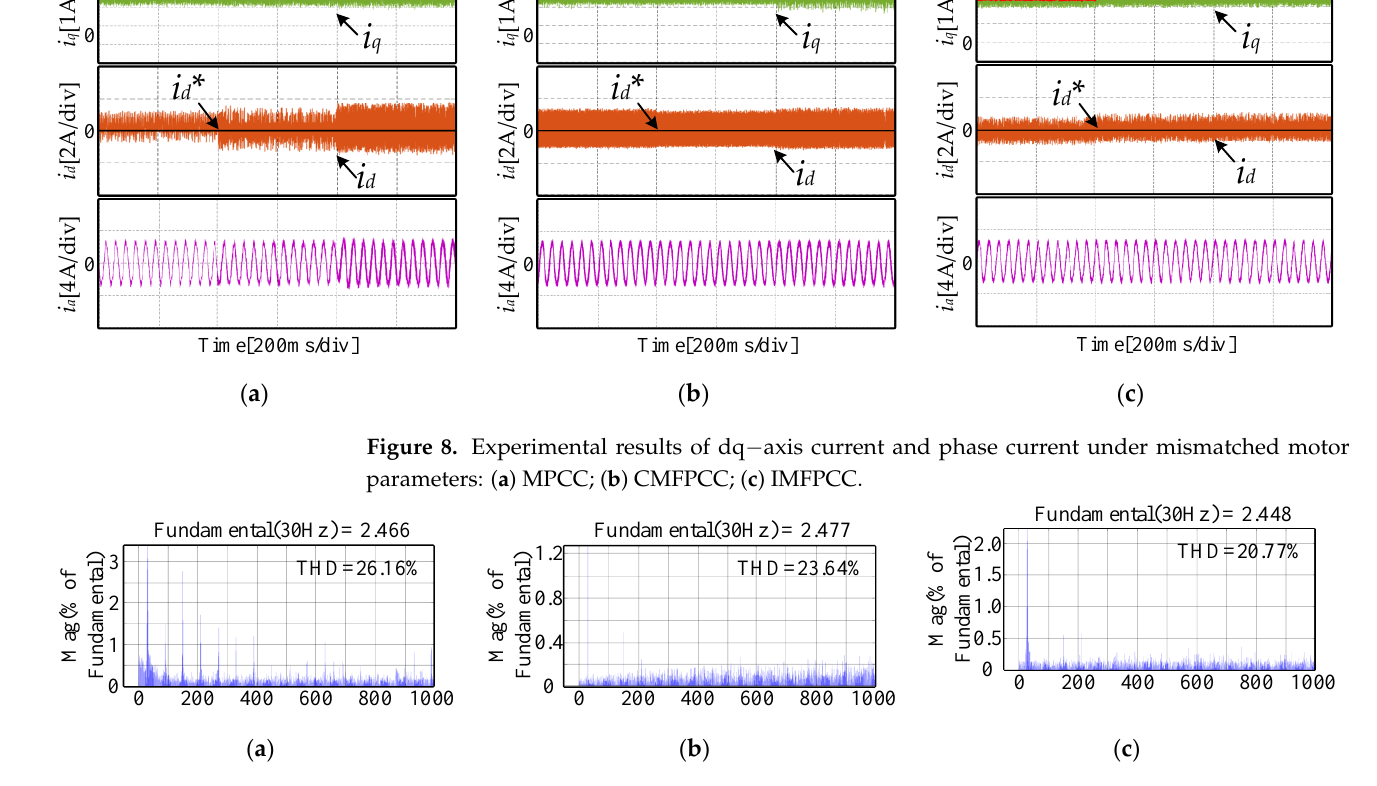
Figure 9. Phase current Fourier analysis of three control strategies under mismatched motor parameters: ( a ) MPCC; ( b ) CMFPCC; ( c ) IMFPCC.